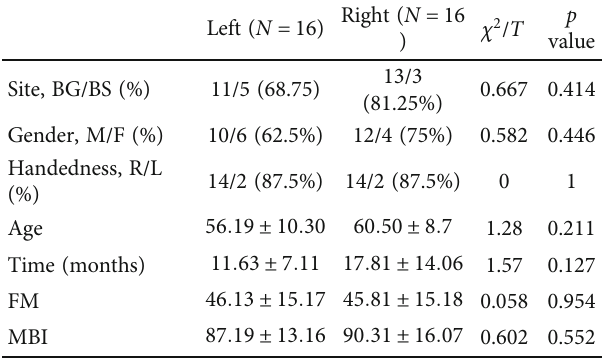
Table 1: Participant characteristics in this